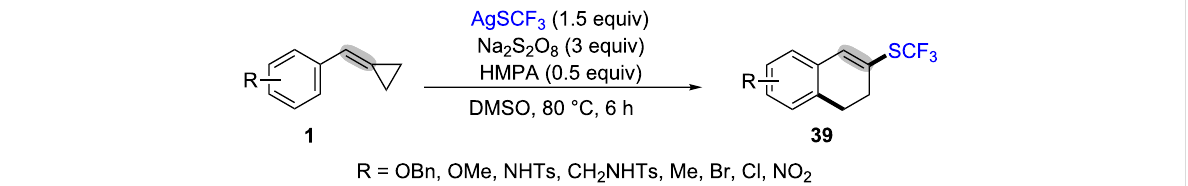
double bond of MCPs 1 generats a more stable benzyl radical 45 . Final ring-opening, intramolecular cyclization, oxidation, and dehydrogenation finally delivers the desired product 41